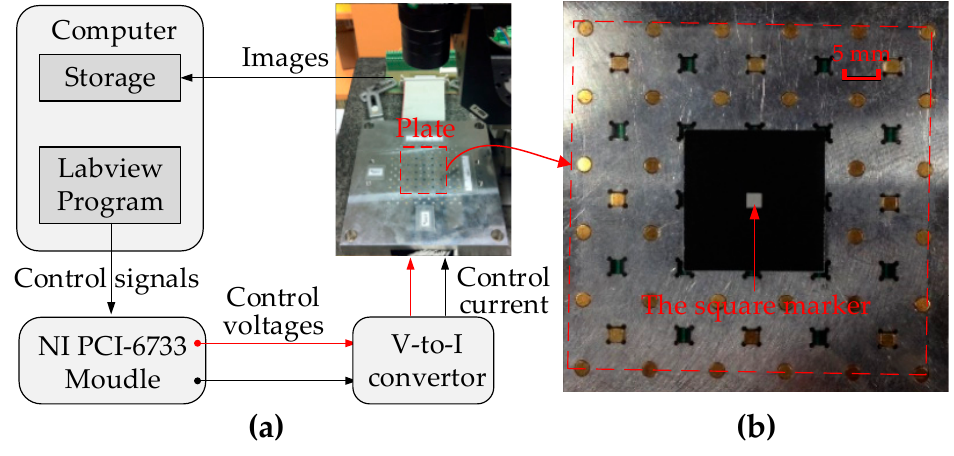
Figure 8. ( a ) Device control system. ( b ) The experimental prototype. LABVIEW software is used for programming and sending control signals to the PCI data acquisition card. The PCI data acquisition card outputs four independent voltage signals, each voltage signal is converted into current signal through the V-A converter and sent to the